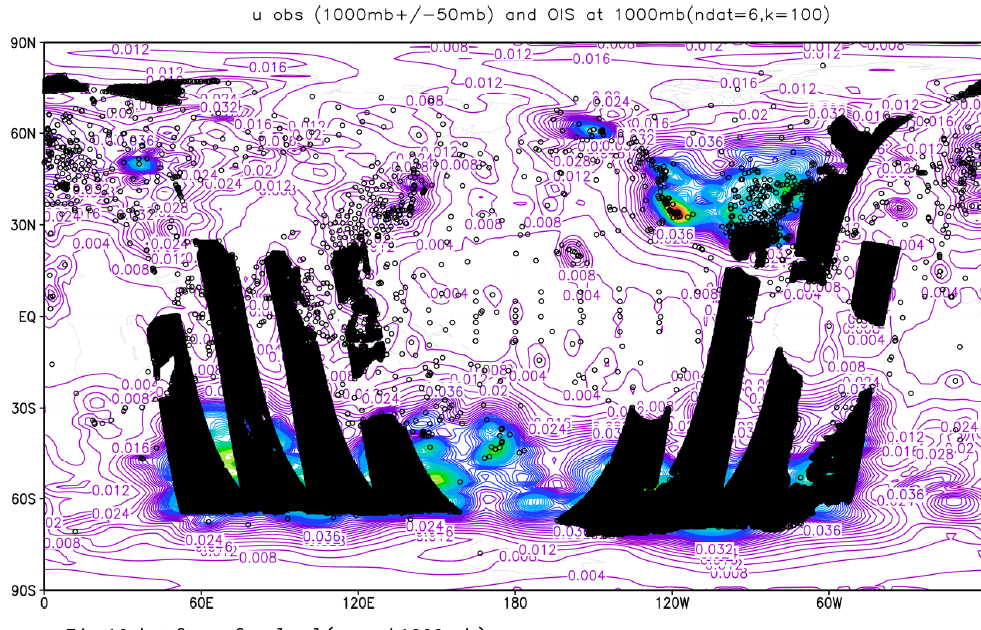
Fig. 11. The same as Fig. 10, but for surface level (around 1000mb).